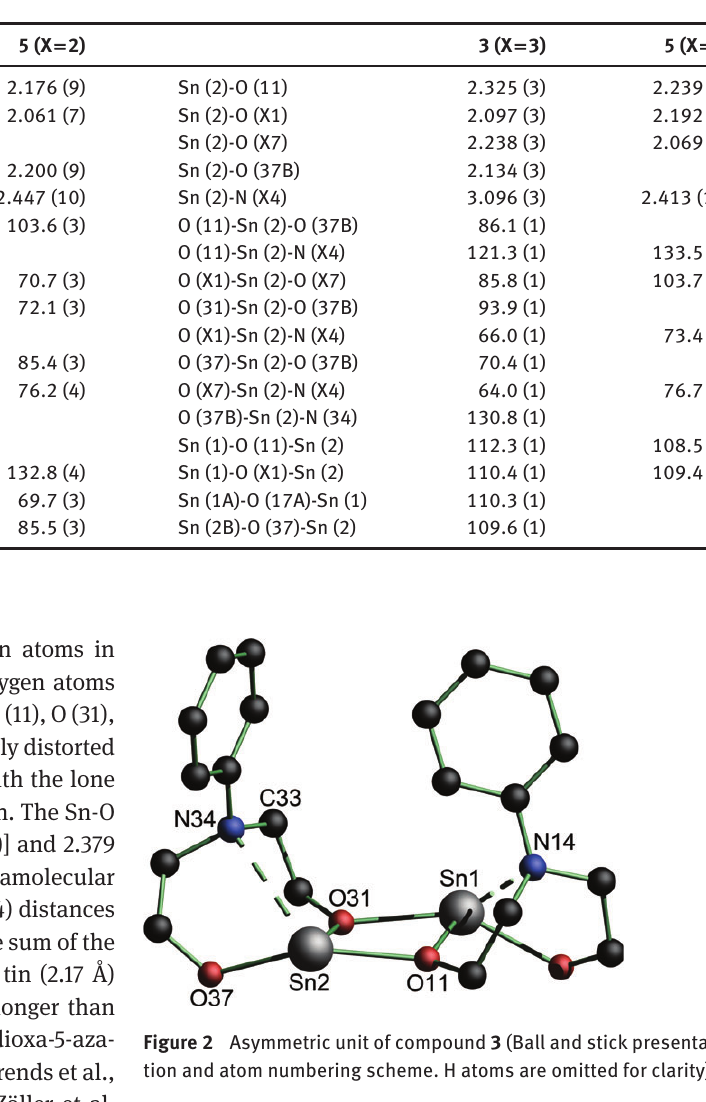
Table 2 Selected bond distances ( Å ) and angles ( ° ) for compounds 3 and [MeN(CH